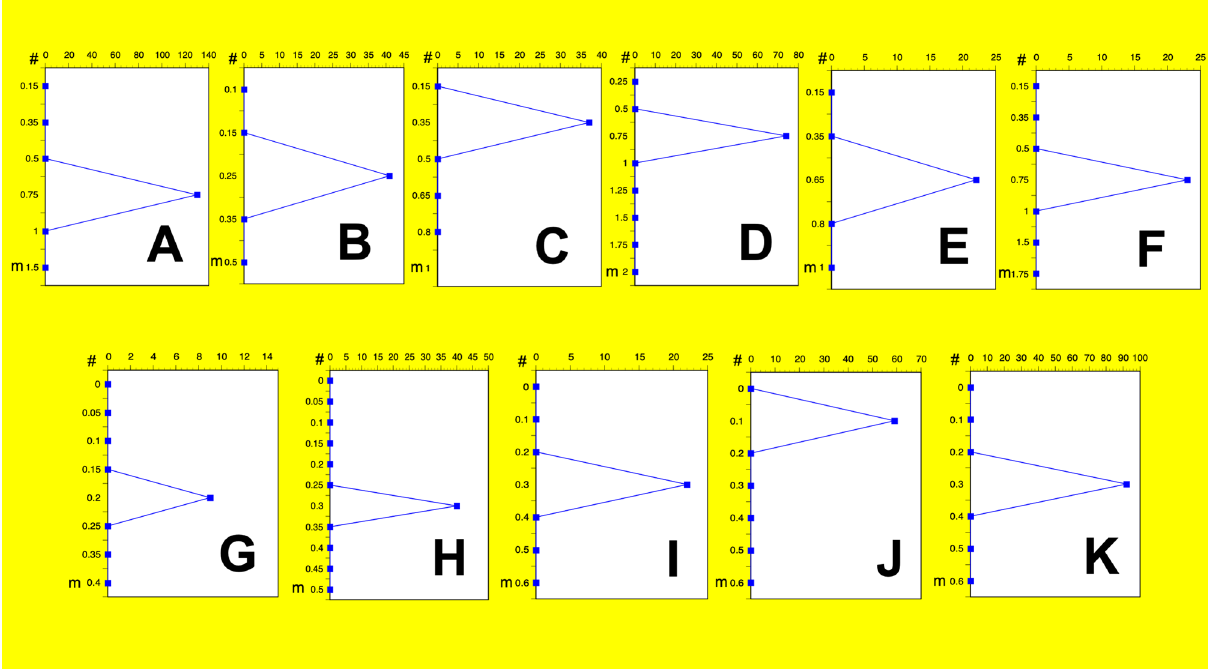
Figure 16. Quantity of Fe and Si-rich microspherules by depth (m): ( A ) Turner earthworks and village, Ohio; ( B ) Moundview village and mound, Ohio; ( C ) Miami Fort hilltop earthworks, Ohio; ( D ) Jennison-Guard village site, Indiana, ( E ) Beech Tree village, Ohio; ( F ) Milford earthworks, Ohio; ( G ) Indian Fort Mountain earthworks, Kentucky; ( H ) Foster’s Crossing earthwork, Ohio, ( I ) Krasnosky earthworks, Ohio; ( J ) Junction earthworks, Ohio; ( K ) Marietta earthworks and mounds, Ohio. Kenneth Barnett Tankersley used Microsoft PowerPoint for Mac Version 16.41 (www. micro soft. com) to create this